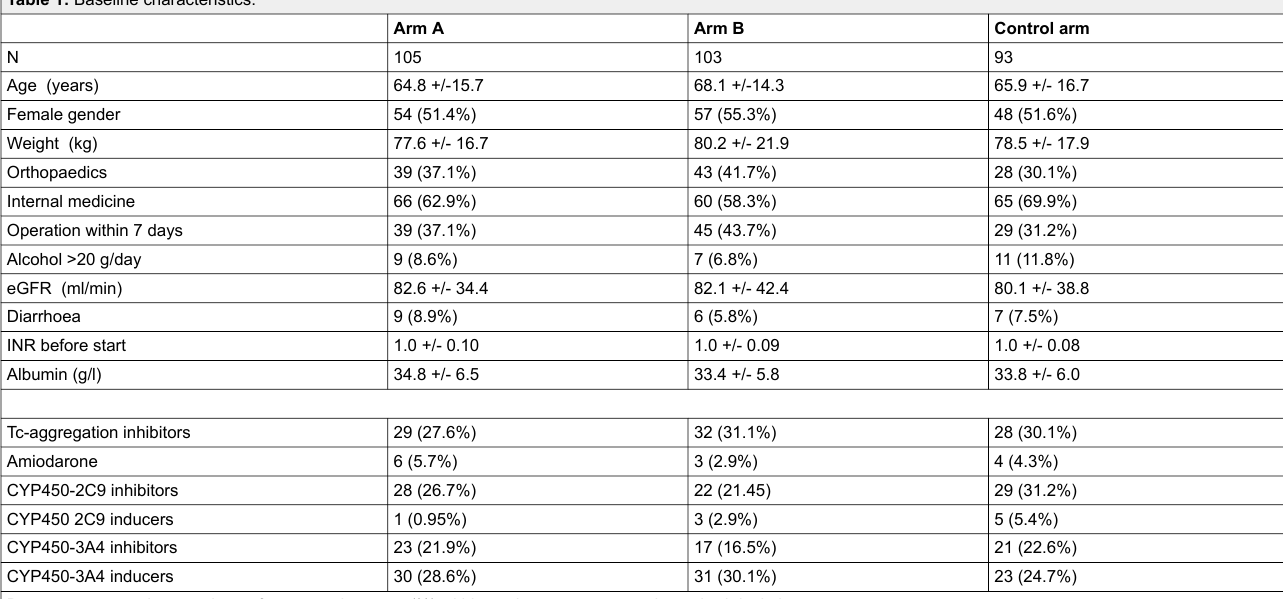
Table 1: Baseline